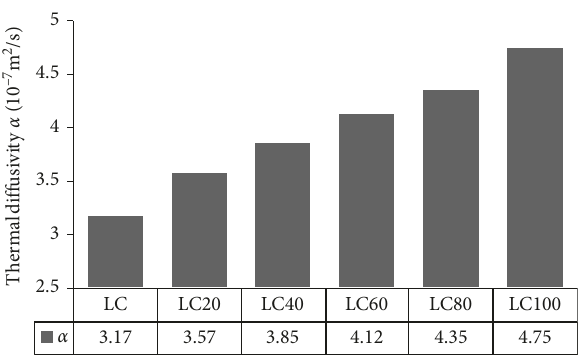
Figure 11: Effect of SWM dosage on the thermal diffusivity of LC at